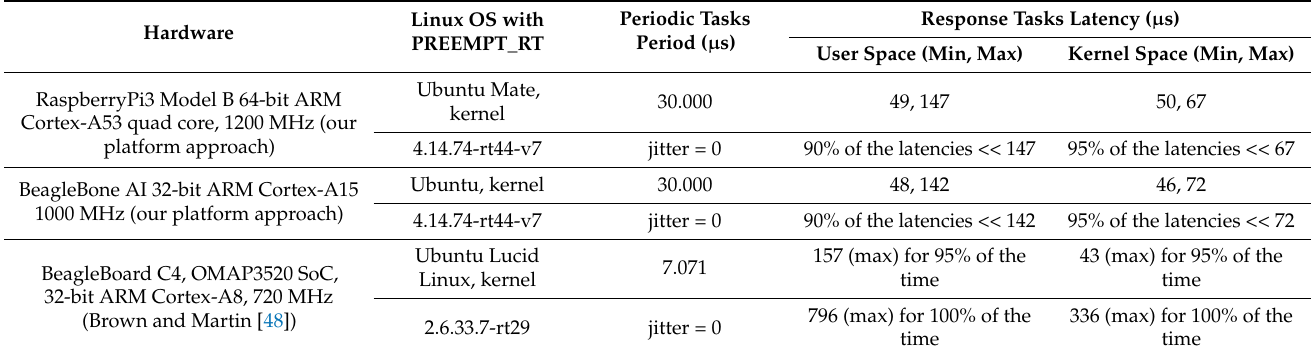
Table 3. Software modules latency results for both approaches under Ubuntu Linux kernels with PREEMPT_RT.